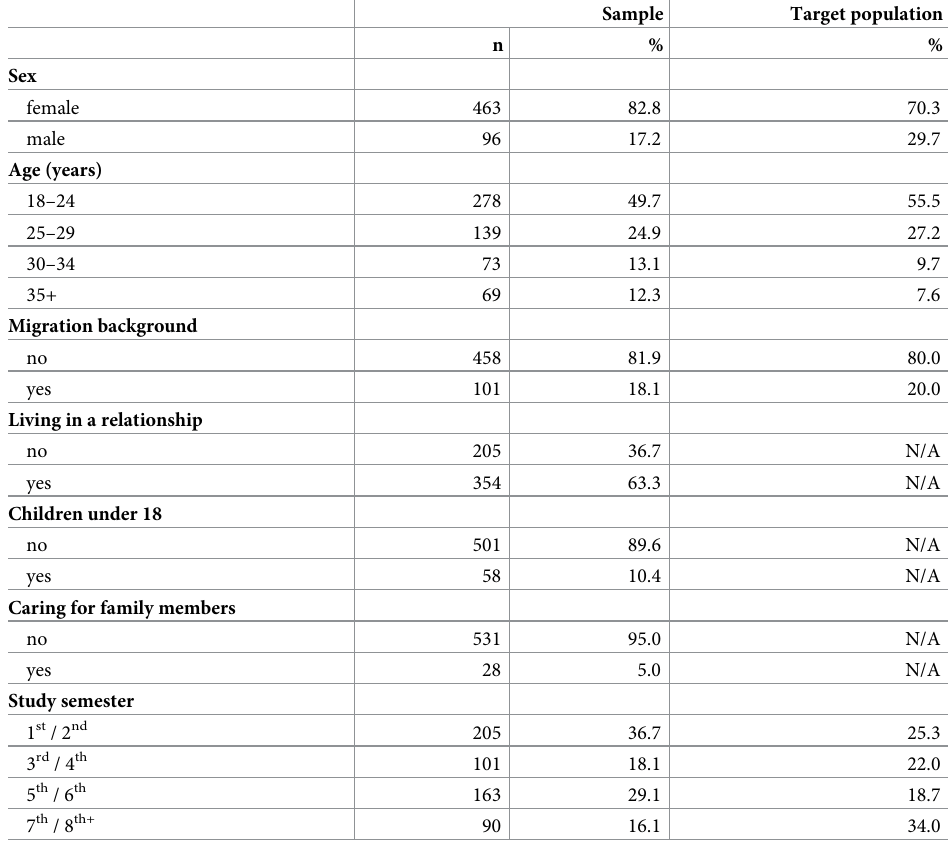
Table 1. Characteristics of the sample and the target population.